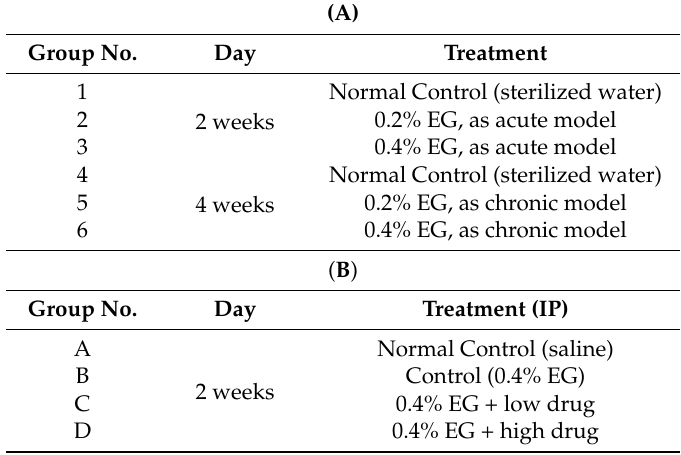
Table 6. Experimental design of urolithiasis induction and anti-urolithiasis activity in the in vivo. (A) Group No.